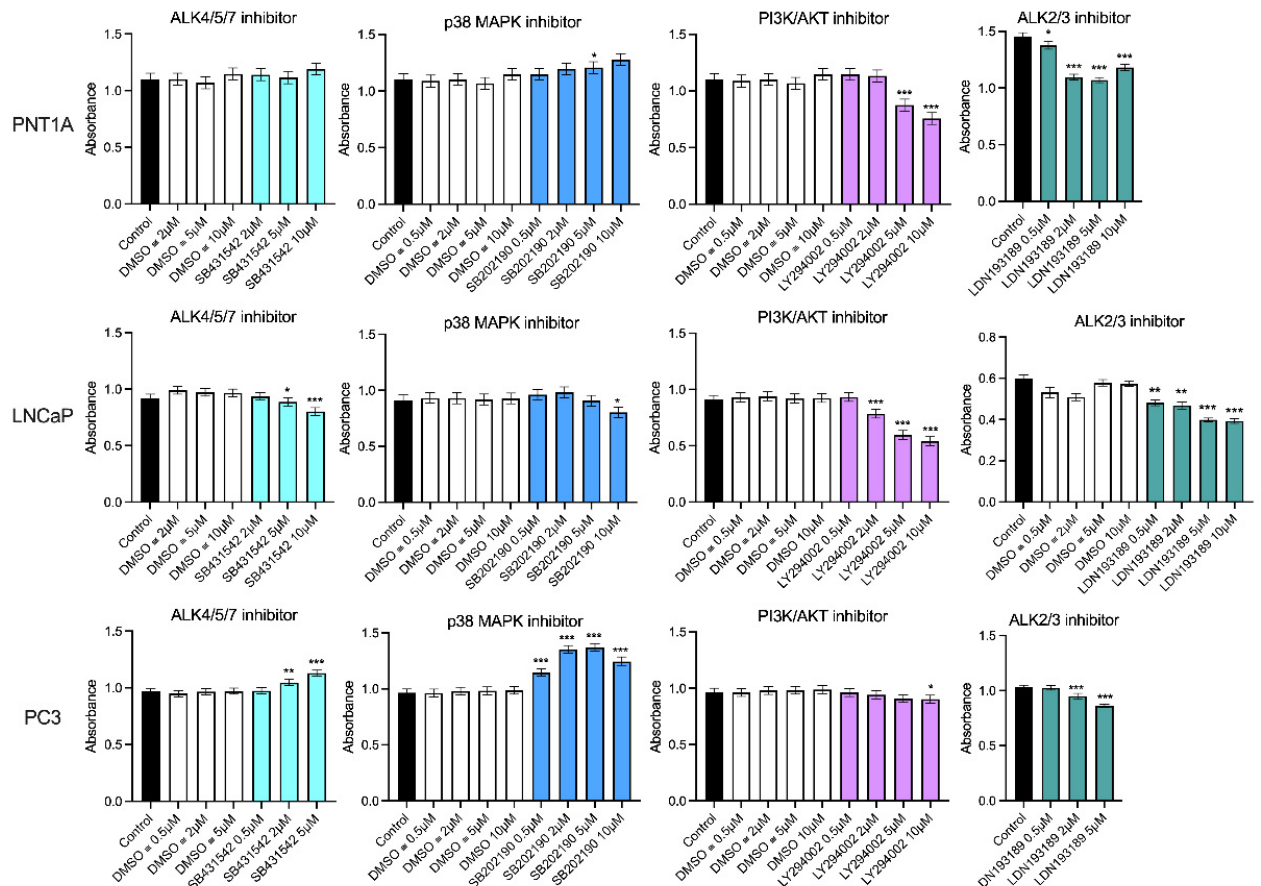
Figure 7. MTS growth assays for prostate cell lines treated with DMSO vehicle control or small molecule pathway inhibitors of ALK4/5/7 (SB431542), p38 MAPK (SB202190), PI3K/AKT (LY294002) and ALK2/3 (LDN193189). The DMSO was used at the equivalent dilution for each inhibitor dose. Data are presented as estimated mean absorbance ± 95% confidence limits from a minimum of three separate passages with three to six wells per assay. * p < 0.05; ** p < 0.01; *** p < 0.001 relative to the DMSO control, analysed by a